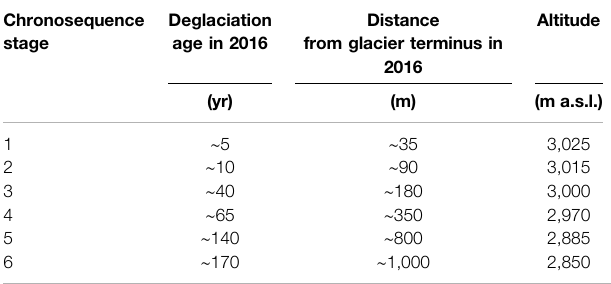
TABLE 1 | Description of the identi fi ed chronosequence